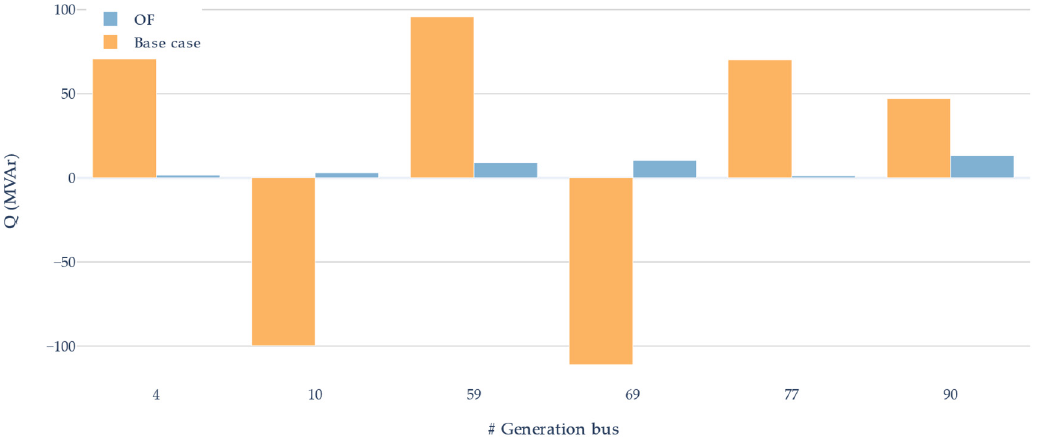
Figure 10. Reactive power outputs of generators (4, 10, 59, 69, 77, and 90) during period 11 for the IEEE 118-bus test system.